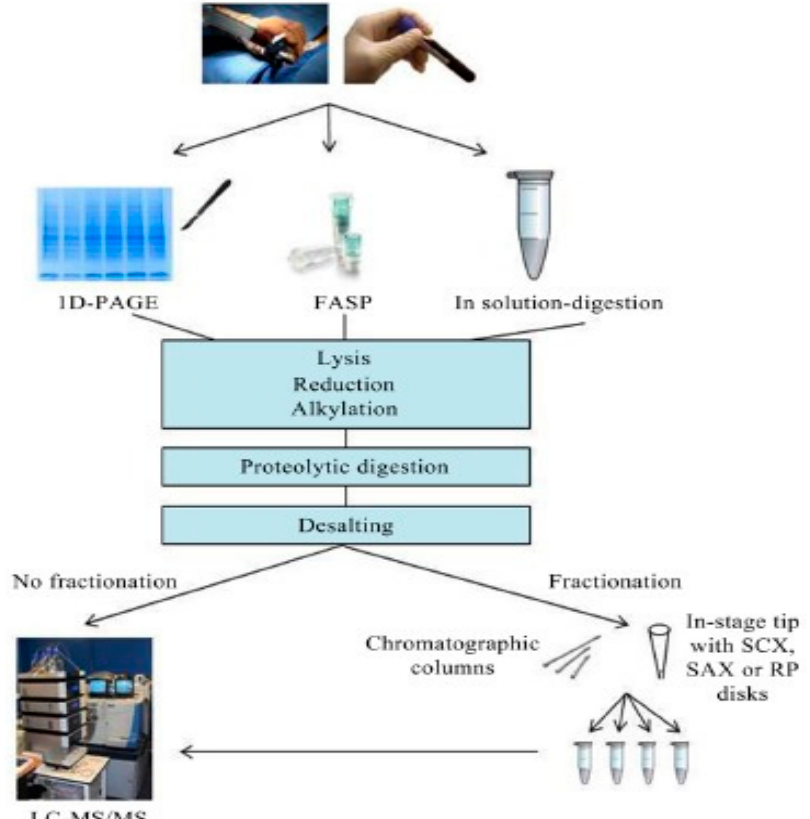
Figure 4. Proteomic workflow comprising three approaches for sample preparation, including filter-assisted sample preparation (FASP). (From Aasebø, E.; Forthun, R.B.; Berven, F.; Selheim, F.; Hernandez-Valladares, M . Global Cell Proteome Profiling, Phospho-signaling and Quantitative Proteomics for Identification of New Biomarkers in Acute Myeloid Leukemia Patients. Curr. Pharm. Biotechnol . 2016 , 17 , 52–70).